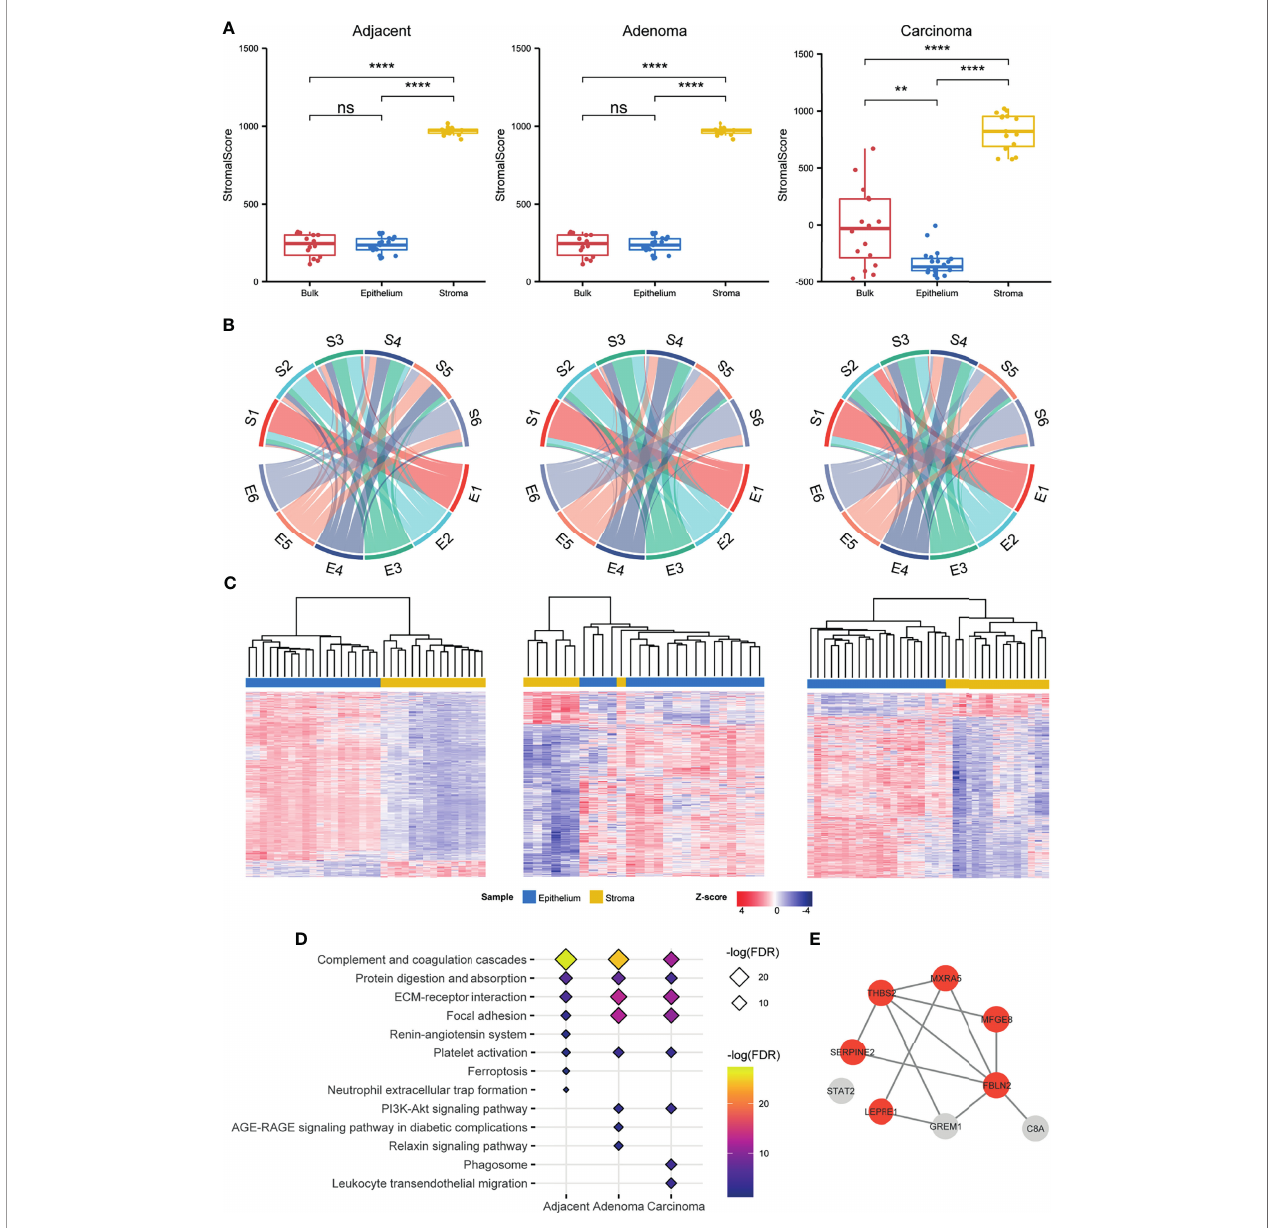
FIGURE 2 | Comparison of the stromal proteomes to the epithelial ones in the adjacent, adenoma, and carcinoma tissues. (A) Evaluation of the in fi ltration level of stromal cells in a preparation by ESTIMATE based on proteomic data. The signs of ** and **** represent a signi fi cance with p < 0.01 and p < 0.0001, respectively, and ns represents nonsigni fi cance. (B) Comparison of the proteomic abundance patterns between stroma and epithelium in three different circumstances using chord plots. Each proteome, stroma (S) or epithelium (E) is evenly divided into six patterns according to the abundance order. (C) Hierarchical clustering for the DEPs between stroma and epithelium in three different circumstances. The normalized abundance is represented by Z-scores. (D) Enrichment of the KEGG pathways for the upregulated DEPs and unique proteins of stroma in three different circumstances. The enriched pathways ranked above top 8 are listed in the plot. (E) The STRING network of nine stromal biomarkers selected through a stringent fi ltration. The circles with orange indicate fi broblast speci fi c